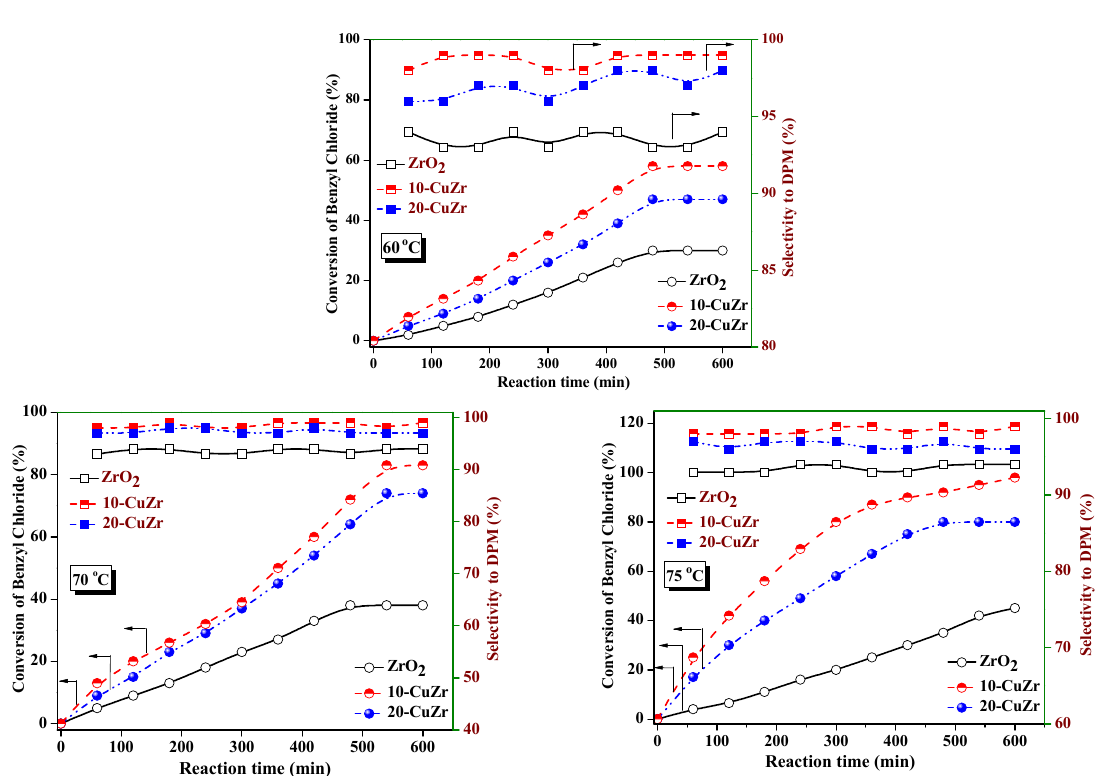
Figure 8. Benzyl chloride conversion levels and diphenylmethane (DPM) selectivities with reaction time over ZrO 2 support, CuZr catalysts at different reaction temperatures (benzne/benzyl chloride stoichiometric ratio = 15 and 0.1 g of catalyst).